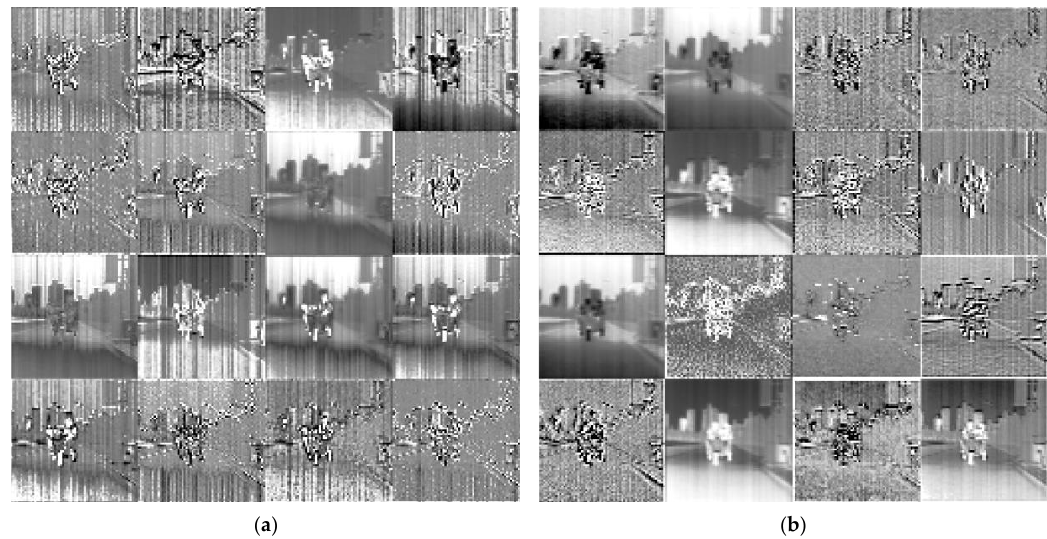
Figure 14. Network intermediate feature maps. ( a ) Infrared feature maps of Pix2Pix; ( b ) the middle feature maps of our model.